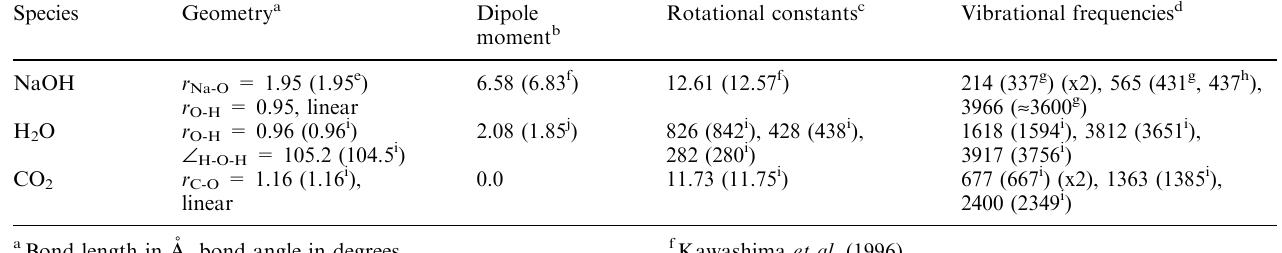
a Bond length in A˚ , bond angle in degrees b In Debye (= 3.336 · 10 ) 30